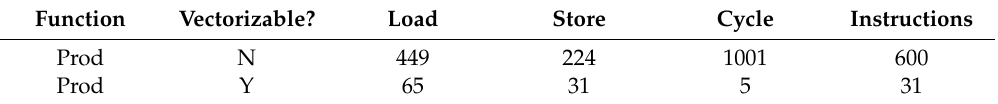
Table 2. Consumption of system resources by the dot product operation. Function Vectorizable?